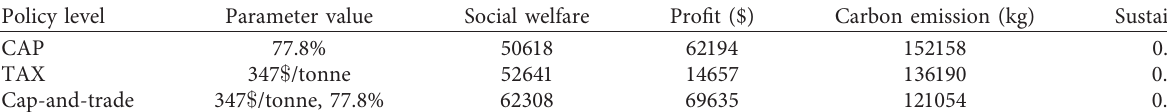
Table 7: Decision results under different carbon policies.